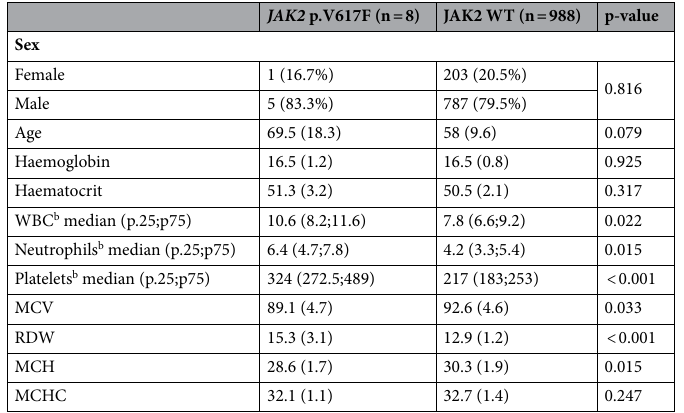
Table 2. Univariate analysis according to JAK2 mutational status. WBC white blood cells, MCV mean corpuscular volume, RDW red cell distribution width, MCH mean corpuscular haemoglobin, MCHC mean corpuscular haemoglobin concentration. a T-Student or Chi-square as appropriate. b Non parametric U-Mann– Whitney.